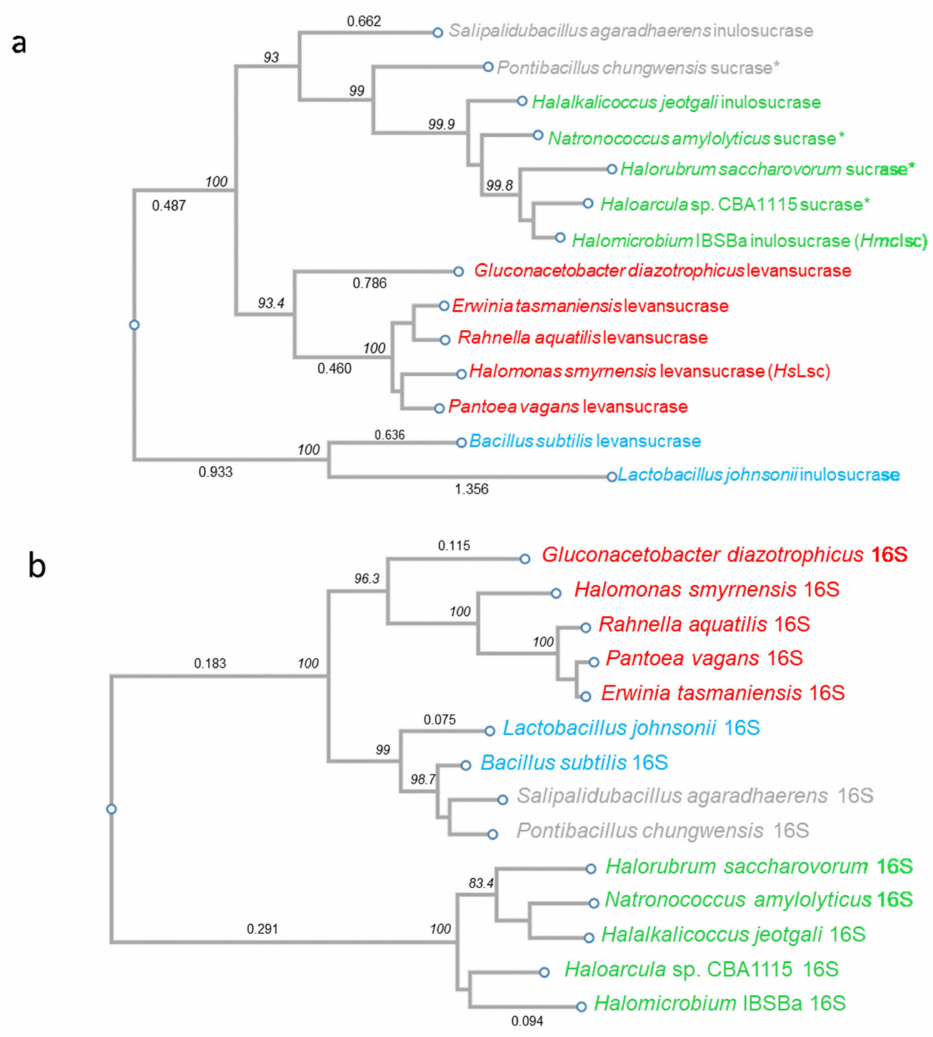
Figure 1. ( a ) Phylogenetic tree based on the protein sequences of GH68 sucrases from selected organisms. These include GH68 sucrases from Gram-positive species, including the inulosucrases from S. agaradhaerens (grey; MF422638.1), the putative inulosucrase from P. chungwhensis (grey; NZ_AVBG01000018.1), the levansucrase from B. subtilis (blue; AY150365.1) and the inulosucrase from L. johnsonii (blue; AE017198.1). Gram-negative GH68 sucrases (red) include those of the G. di- azotrophicus levansucrase (AY853402.1), the E. tasmaniensis levansucrase (X75079.1), the R. aquatilis levansucrase (AY027657.1), the H. smyrnensis levansucrase (KC480580.1) and the predicted levan- sucrase from P. vagans (CP014127.2). Among the Haloarchaea (green), the H. jeotgali inulosucrase (CP002062.1), the N. amylolyticus putative inulosucrase (NZ_AOIB01000038.1), the predicted inu- losucrase from H. saccharovorum (NZ_AOJE01000020.1) , the putative inulosucrase from Haloarcula sp. CBA1115 (CP010529.1) and Hmc Isc (this work) are depicted. *indicates that the inulosucrase functionality has not yet been proven. ( b ) Phylogenetic tree based on the DNA sequences of 16S rDNA from selected microorganisms. These are derived from Gram-negative bacteria (red) including those of G. diazotrophicus (NR_027591.1), H. smyrnensis (NR_115697.1), R. aquatilis (MN826572.1), P. vagans (CP038853.1) and E. tasmaniensis (NR_074869.1). Sequences from Gram-positive bacteria (include those of L. johnsonii (blue; LIGY000026.1), B. subtilis (blue; MT605348.1), S. agaradhaerens (grey; FN432808.1) and P. chungwhensis (grey; NR_025812.1). Among the Haloarchaea (green), Haloar- cula sp. CBA1115 (LC198783.1), Halomicrobium IBSBa (MK208532), H. saccharovorum (NR_113484.1), H. jeotgali (LT634701.1) and N. amylolyticus (NR_028217.1) are considered. The two species in grey changed position between the GH68 ( a ) and 16S ( b ) phylogenetic trees. Bootstrap values (italic, %) are indicated. A number of branch length labels are indicated (not